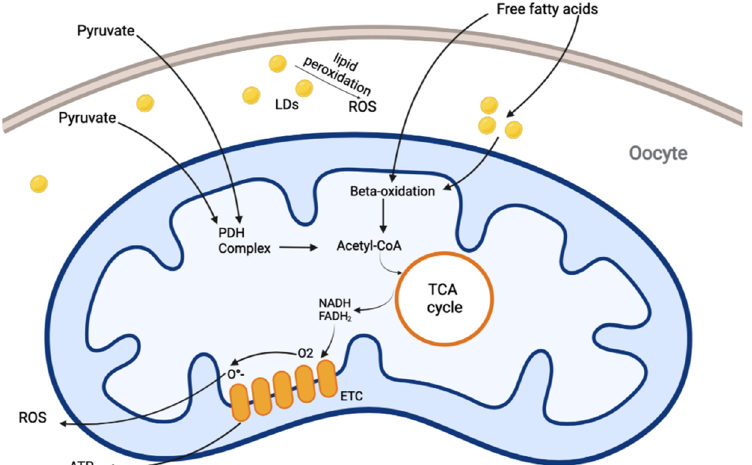
Figure 1. Mitochondrial pyruvate and fatty acid metabolism. Pyruvate from cumulus cells, follicular fluid, or culture medium enter the oocyte and is converted to acetyl-CoA by PDH complex. Free fatty acids are taken up into the oocyte to form an endogenous store in the form of lipid droplets (LDs). It is also possible that free fatty acids enter the mitochondria to undergo beta-oxidation. TCA cycle consumes acetyl-CoA and reduces NAD + to NADH and FAD to FADH 2 . These factors are than oxidized by the electron transport chain to generate ATP through oxidative phosphorylation. The ETC can allow leakage of electrons back into the mitochondrial matrix, producing the superoxide radical (O 2− ). In the case of excess lipid intake, free fatty acids remain in the cytoplasm where they can generate lipid peroxides. A fine regulation of pyruvate and fatty acids metabolism is required to maintain energetic homeostasis, avoiding excess ROS production with negative effects on oocytes.